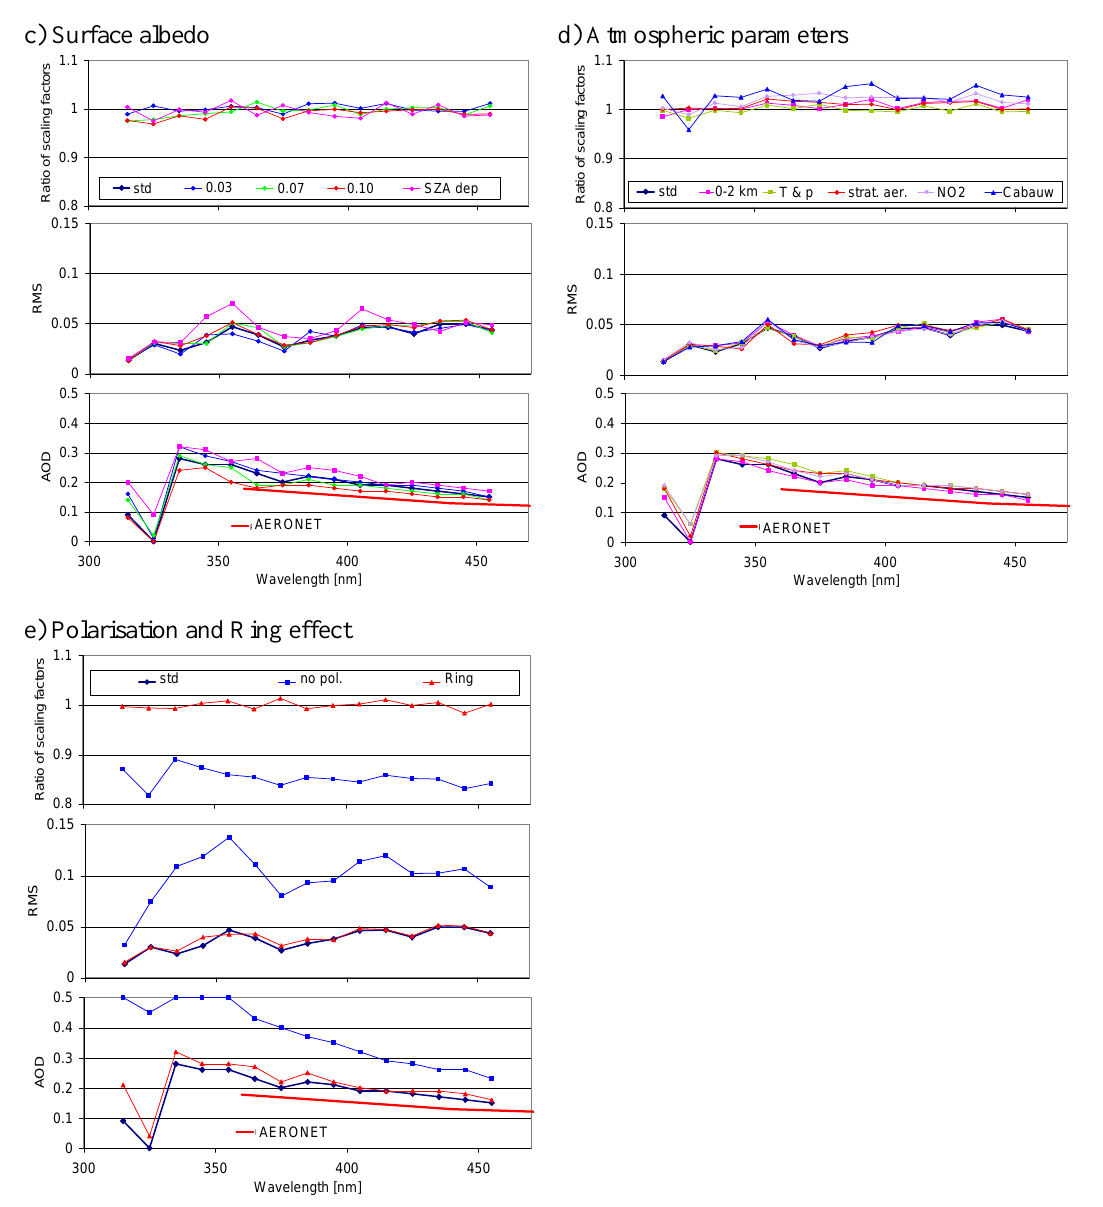
Figure 8. Comparison of the derived scaling factors, rms and AOD, for different scenarios (the scaling factors for the standard scenario are divided by the scaling factors for the different scenarios; see Table